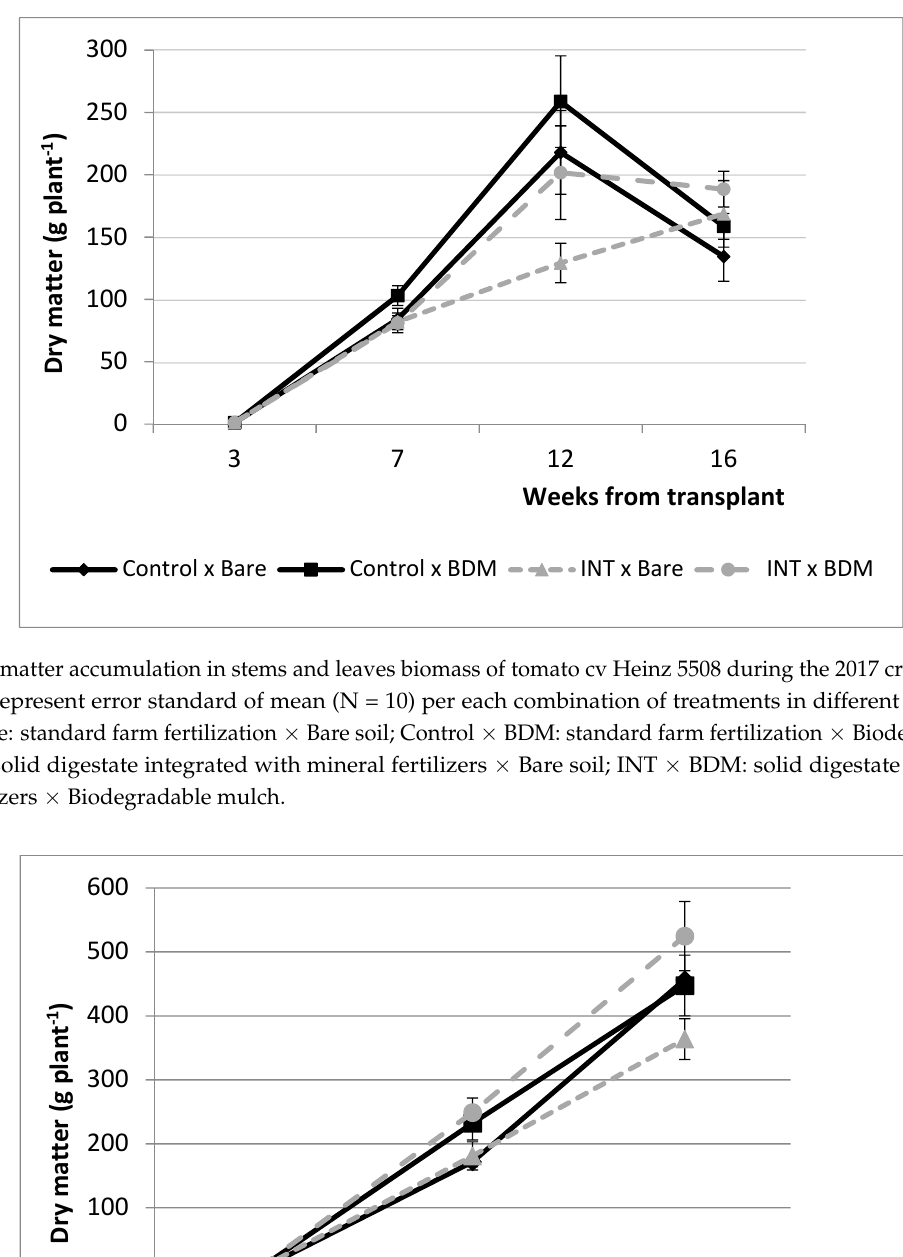
8 of 19 Table 3. Minimum and maximum temperature (°C), cumulated rain expressed as monthly means from April to August 2017 and 2018 in Grazzanise (Caserta). 2017